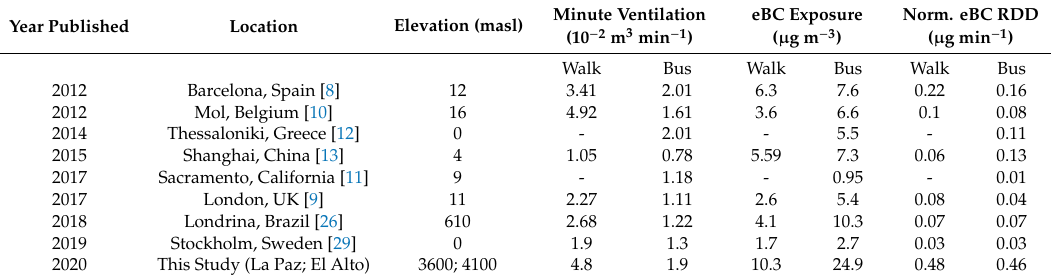
Table 5. Summary of minute ventilation (MV), eBC exposure and normalized eBC RDD (Norm. eBC RDD) from di ff erent studies. The table presents black carbon mass concentration measured by micro-aethalometer as